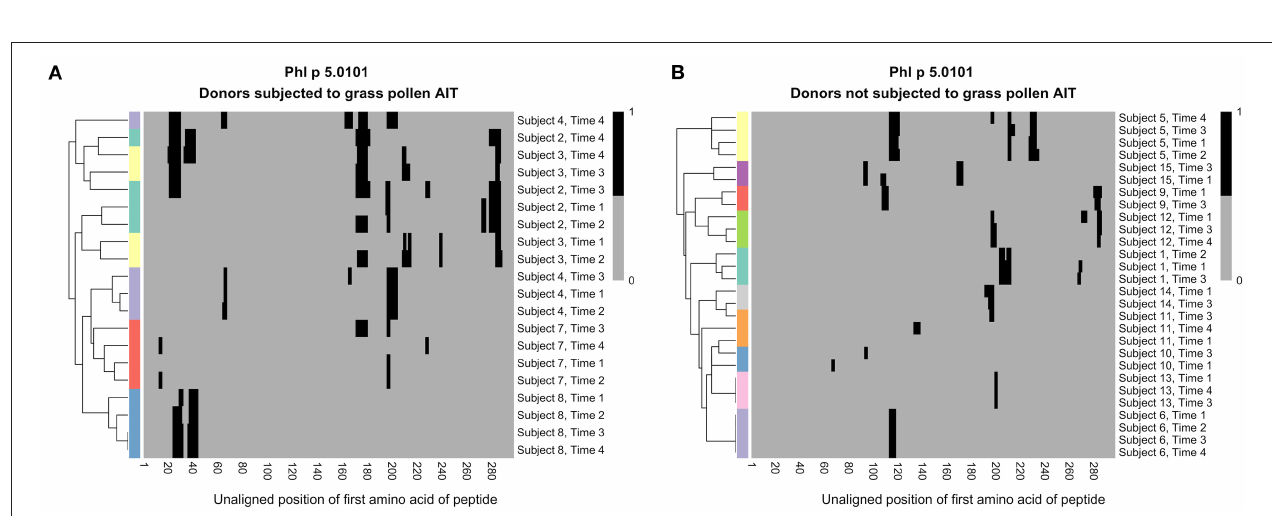
FIGURE 2 | Total number of linear epitopes in allergens of three grass species ( Lolium perenne, Dactylis glomerata , Phleum pratense ) recognized by IgG (A) , IgG4 (B) , and IgE (C) in individuals that had (black) or had not (gray) been treated with AIT containing extract from these three, and two additional ( Alopecurus pratensis and Festuca pratensis ), grass species. Samples had been collected at treatment initiation (time 1), and 8 weeks (time 2), 1 year (time 3), and 3 years later (time 4). *Timepoints with a significant difference between treated and untreated individuals, using Mann–Whitney U -test and p -value < 0.05.